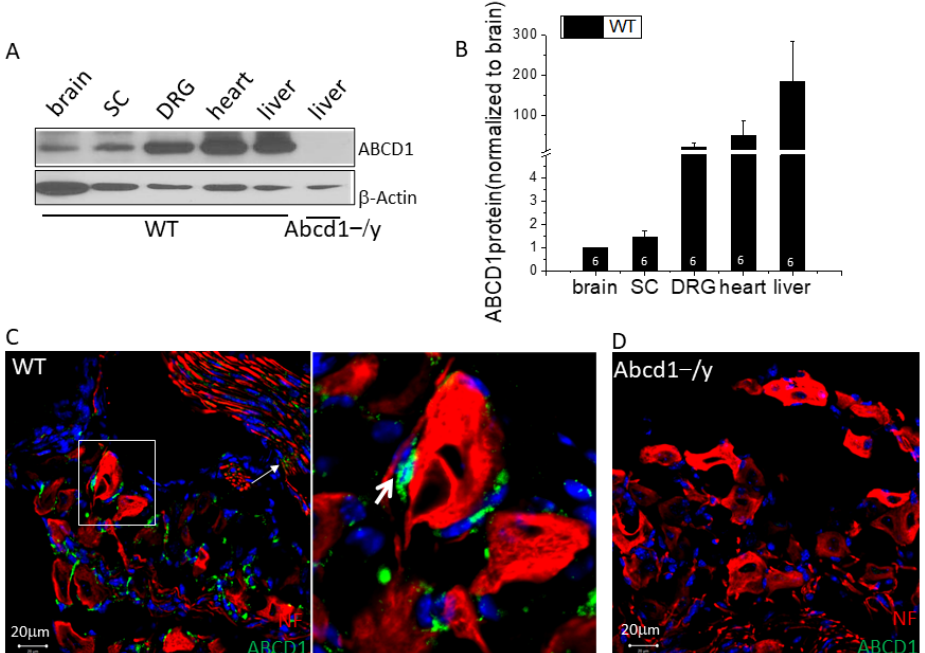
Figure 1. Within the nervous system, ABCD1 protein is highest in satellite glial cells (SGC) of dorsal root ganglia (DRG). ( A ) Representative Western blot image showing ABCD1 protein expression in different mouse organs with Abcd1 − /y mouse DRG tissue as negative control. SC = spinal cord ( B ) ABCD1 protein level in different organs of WT mice was quantified by image J with β -ACTIN as loading control (n = 6). ( C ) Representative confocal images showing ABCD1 mainly expressed in SGCs (thick arrow) that surround DRG neurons; Schwann cells (thin arrow) surrounding axons also show ABCD1 expression. Magnification shows the close proximity of ABCD1 to the neuronal membrane surface. ( D ) In Abcd1 − /y DRG, there is no ABCD1 detectable in SGCs. Bar = 20 μ m. Results were expressed as means ±SEM.